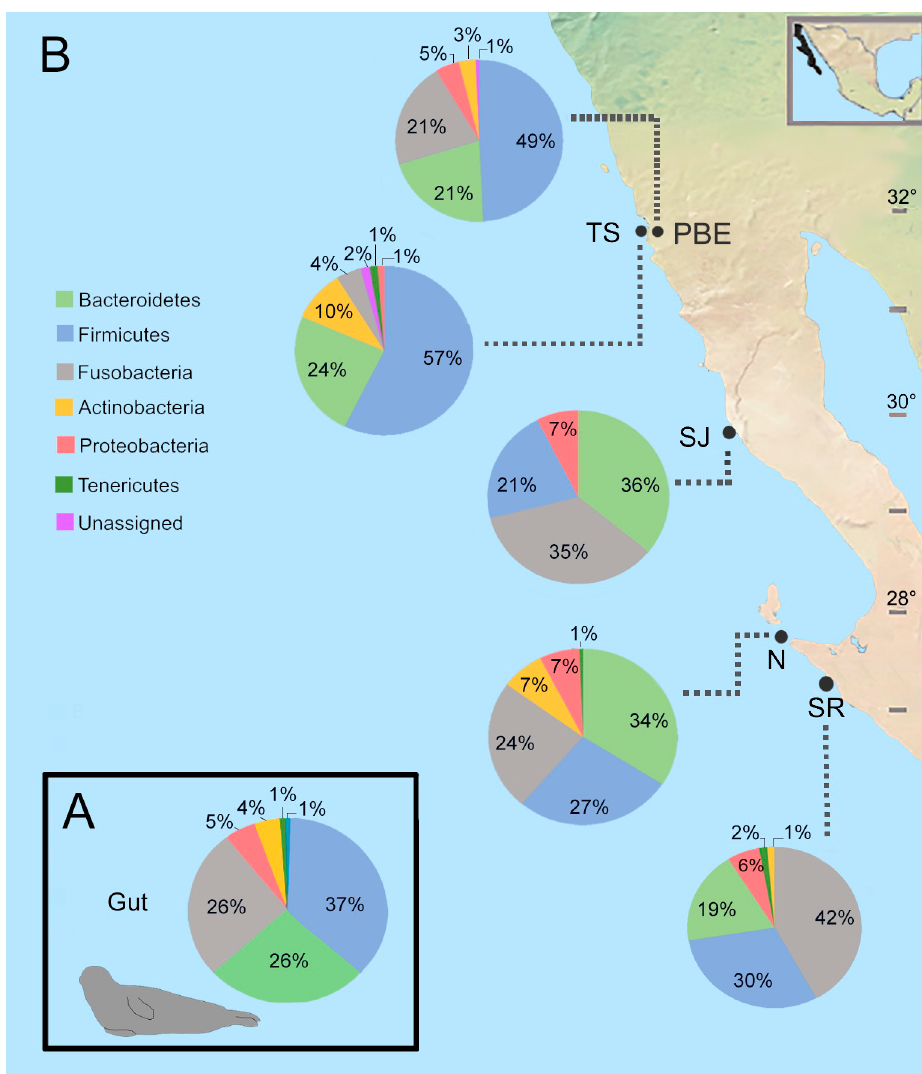
Fig 1. Bacterial phyla in harbor seal gut microbiota. (A) Overall composition of gut microbiota at the phyla level. (B) Average relative abundance of the most common bacterial phyla in the harbor seal colonies, only taxa with > 1% relative abundance are shown. Harbor seal sampling locations on the western coast of Baja California are included in the figure as PBE = Punta Banda Estuary, TS = Todos Santos Island, SJ = San Jeronimo Island, N = Natividad Island, SR = San Roque